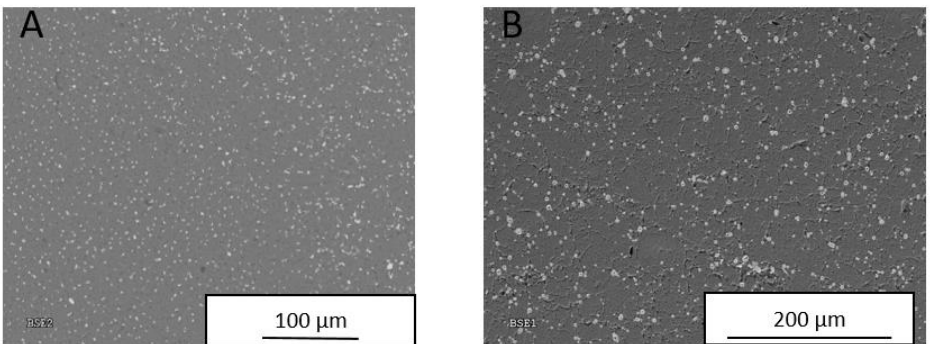
Figure 2. SEM images of ceramic–metal composites microstructures: ( A ) composite Al 2 O 3 -Ni, uniform distribution of Ni particles in ceramic matrix; ( B ) composite Al 2 O 3 -Fe, Fe particles located at triple points and at ceramic grain boundaries. Source: results obtained under supervision of K. Konopka.